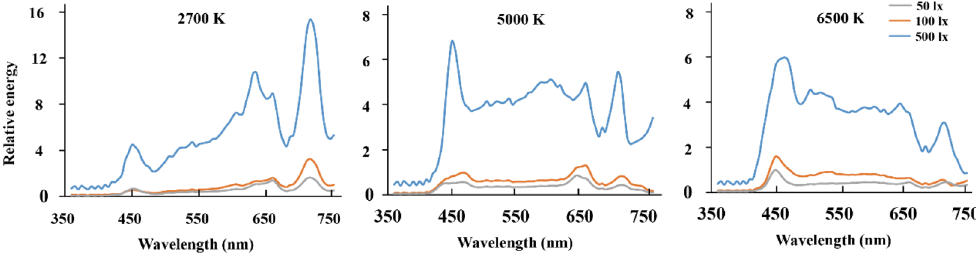
Figure 4. Relative spectral distribution of different light conditions: left: 2700 K, middle: 5000 K; right: 6500 K; Gray: 50 lx; Orange: 100 lx; Blue: 500 lx.